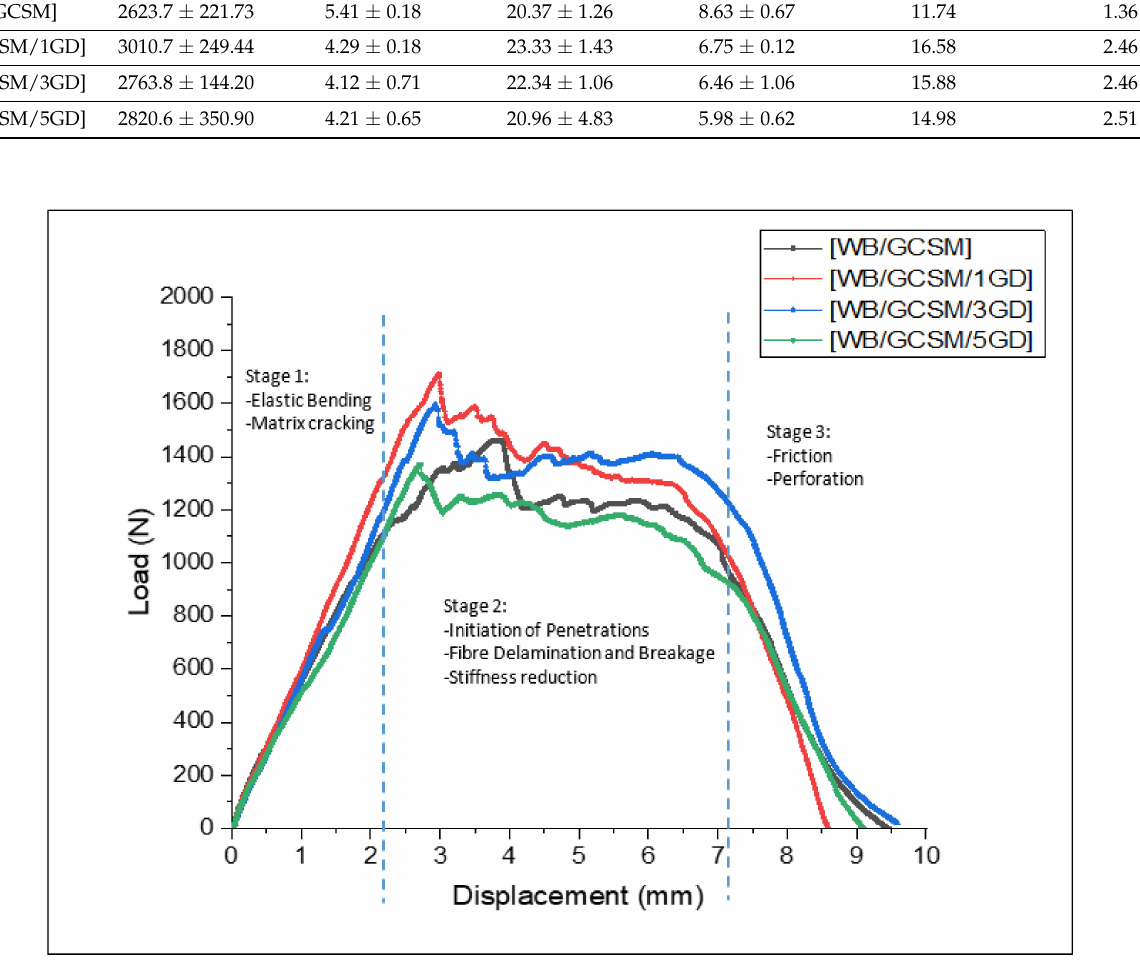
Figure 6. Typical load–displacement of [WB/GCSM], [WB/GCSM/1GD], [WB/GCSM/3GD] and [WB/GCSM/5GD]